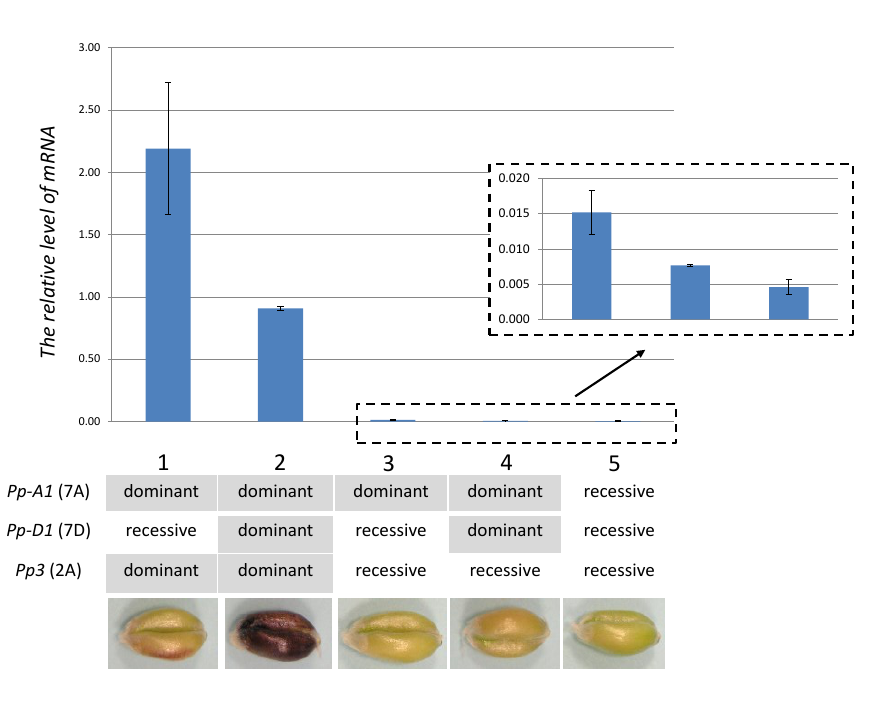
Figure 6. TaMyc1 transcription in the pericarp of NILs carrying various combinations of Pp alleles. 1: “i:S29 Pp-A1pp-D1Pp3 P ” NIL, 2: “i:S29 Pp-A1Pp-D1Pp3 P ” NIL, 3: cv.